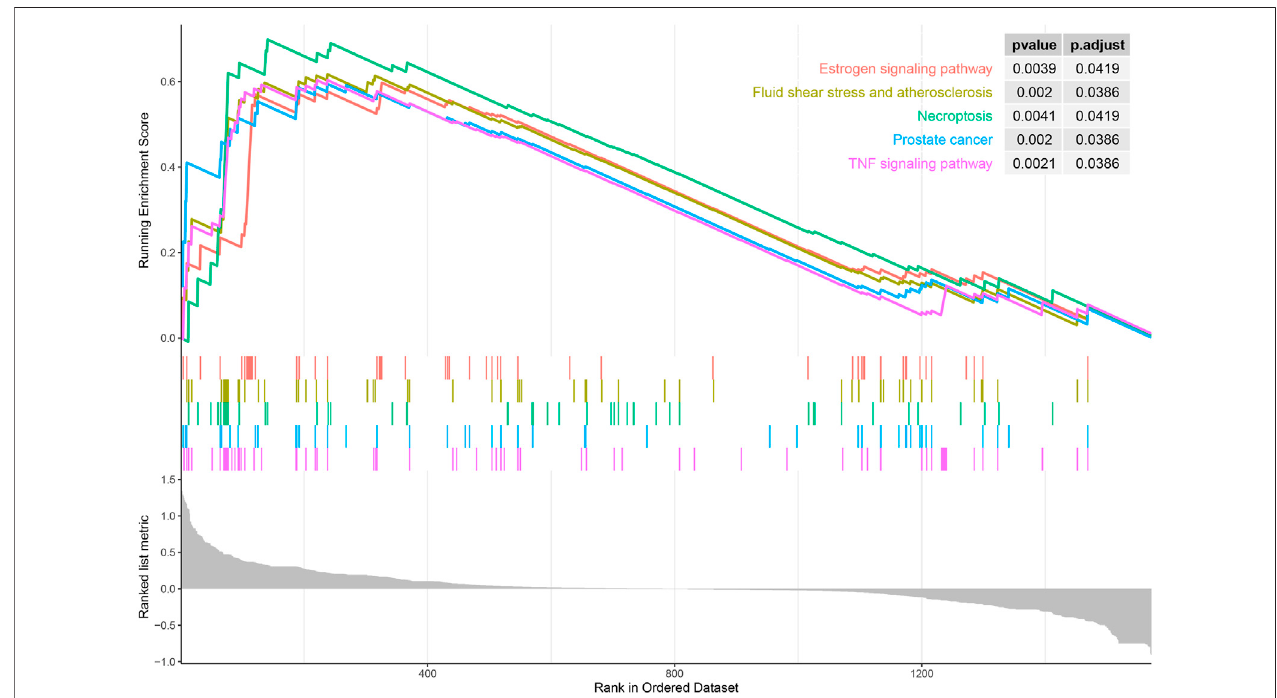
FIGURE 3 | Gene set enrichment analysis (GSEA) of all immune-related genes in the training set (top fi ve according to normalized enrichment score).